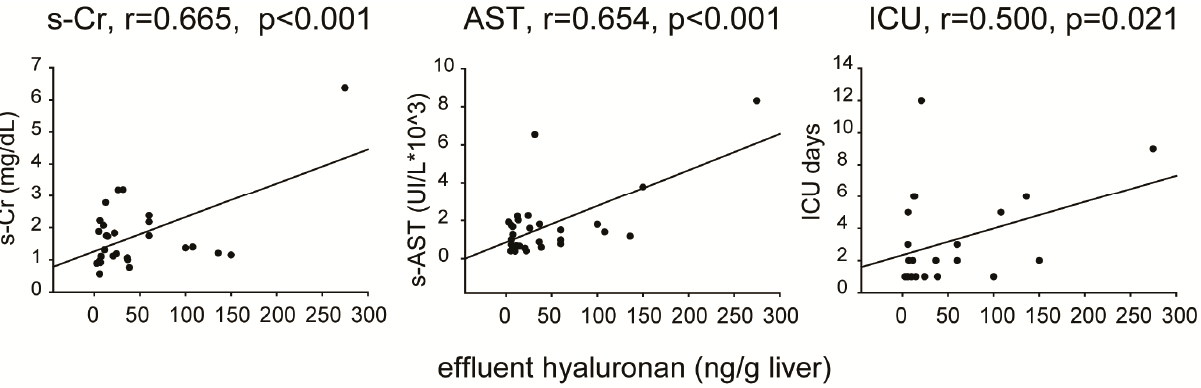
Figure 4. Linear regression analysis between effluent HA concentration and recipient parameters. s-CR, serum creatinine; s-AST, serum aspartate amino transferase; ICU, intensive care unit stay.